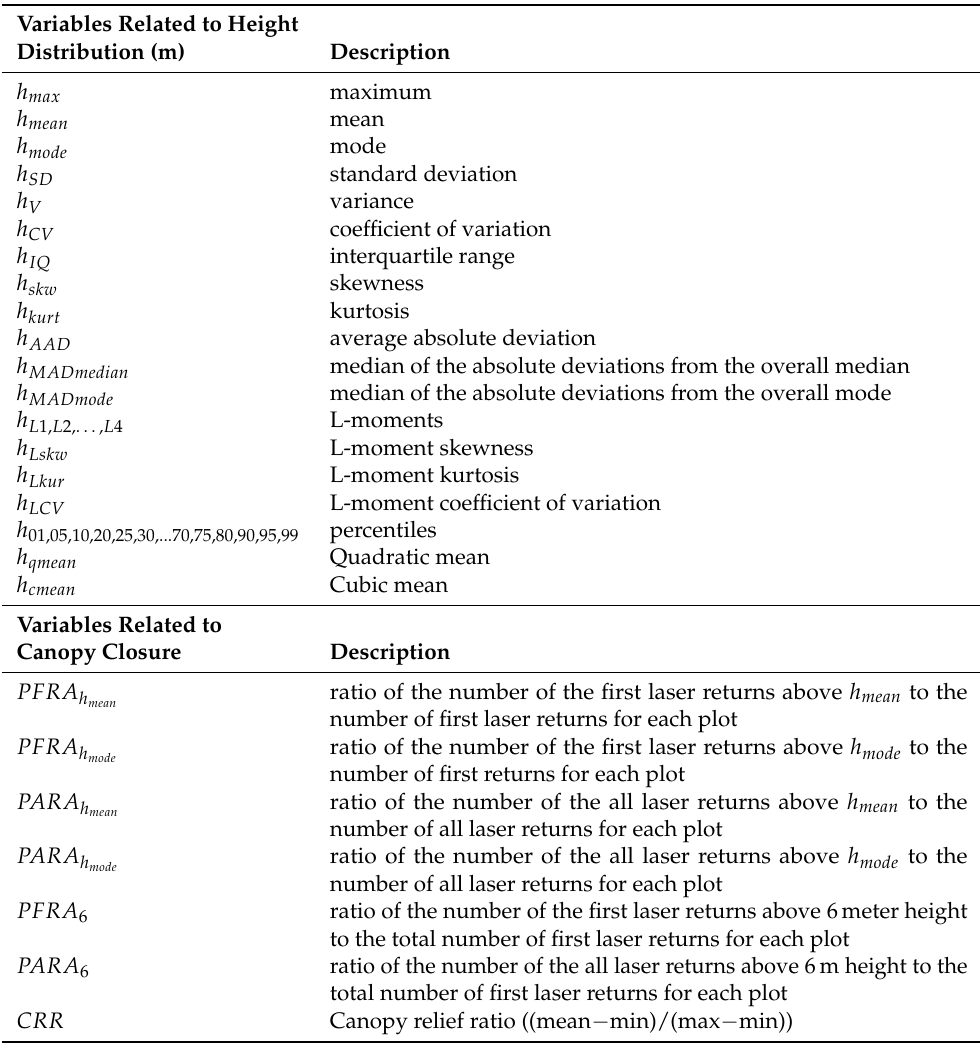
Table 1. ALS point cloud metrics calculated from the height distribution of the normalized returns for each inventory